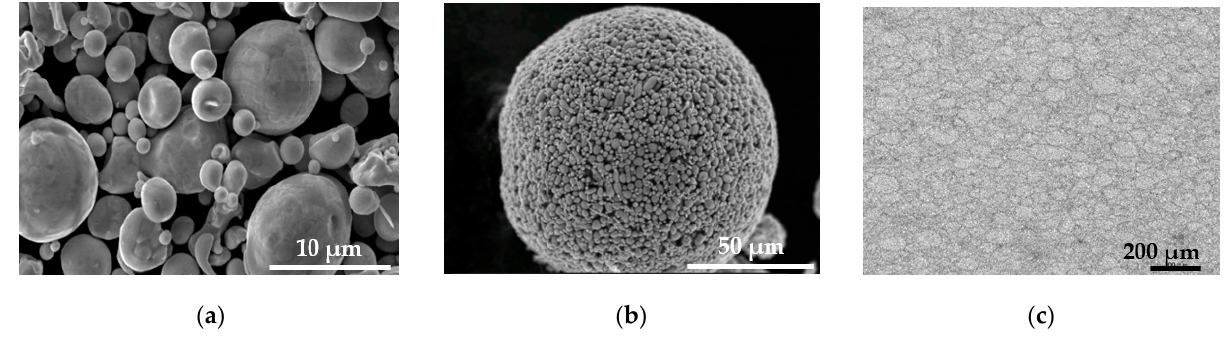
Figure 1. SEM images of water-atomized powders and granulated powder, and OM picture in cross- section of compact. ( a ) Raw powders; ( b ) granulated powder; ( c ) granulated powders after pressing.